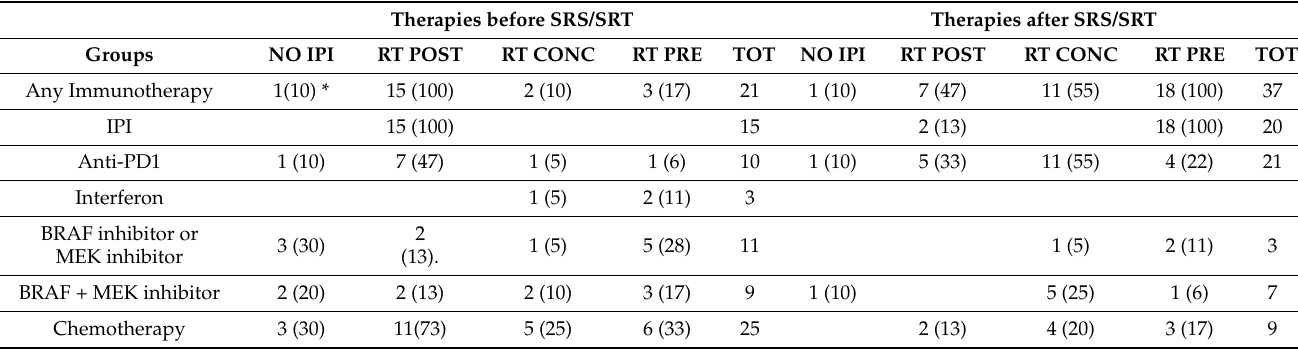
Table 2. Systemic therapies performed before and after SRS/SRT. Therapies before